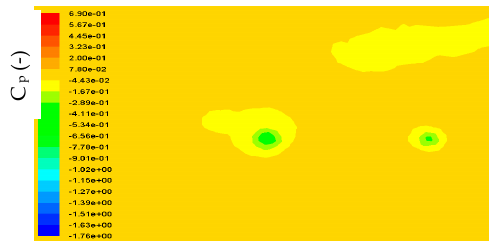
Figure 14. The low-pressure coefficient at the centre of the vortices at 0-degree angle of attack.